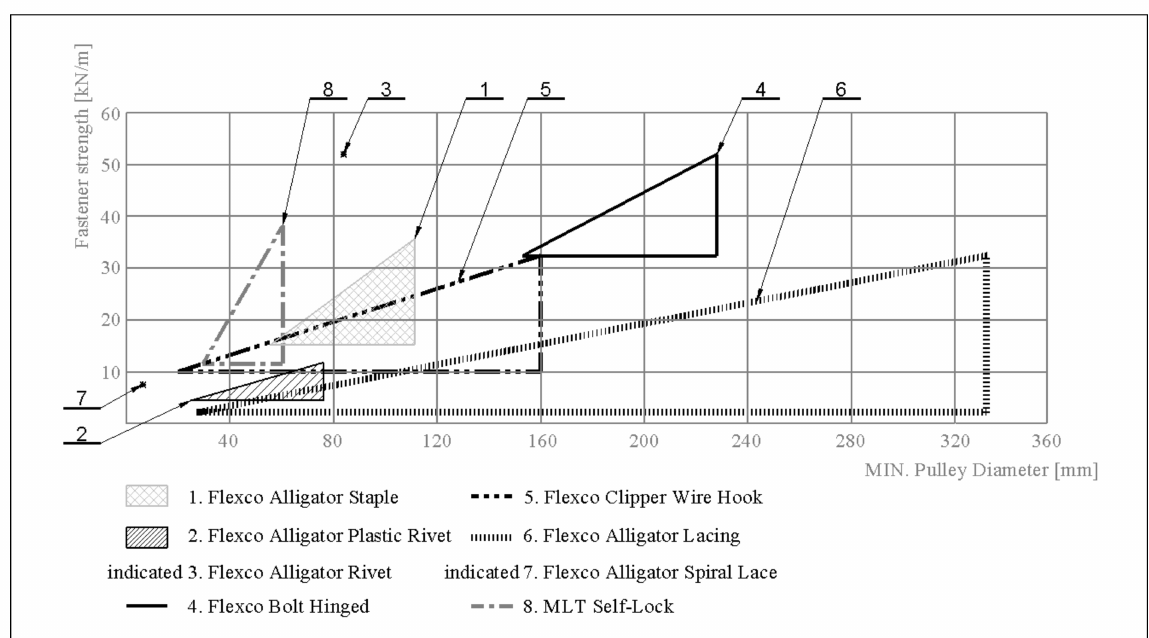
Figure 28. Design map for the selection of a mechanical connection in the range of MIN. Pulley diameter from 0 to approximately 360 mm and in the range of fastener strength from 0 to approximately 60 kN/m.